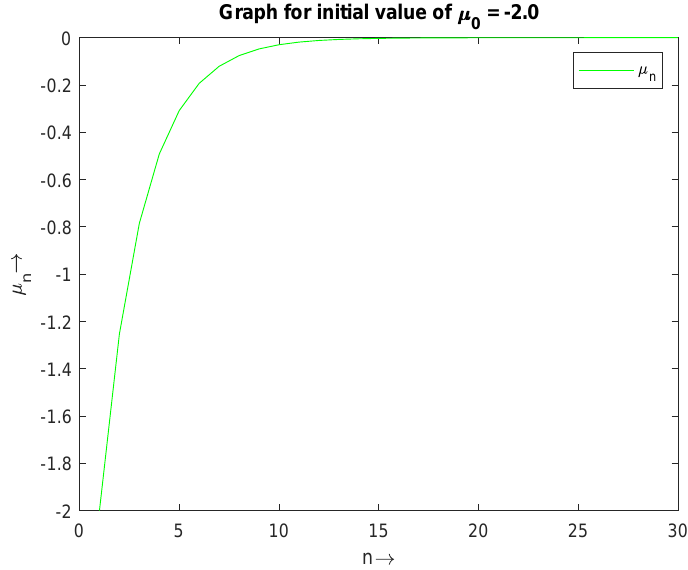
Figure 3. The convergence of { µ n } with initial value µ 0 = − 2.